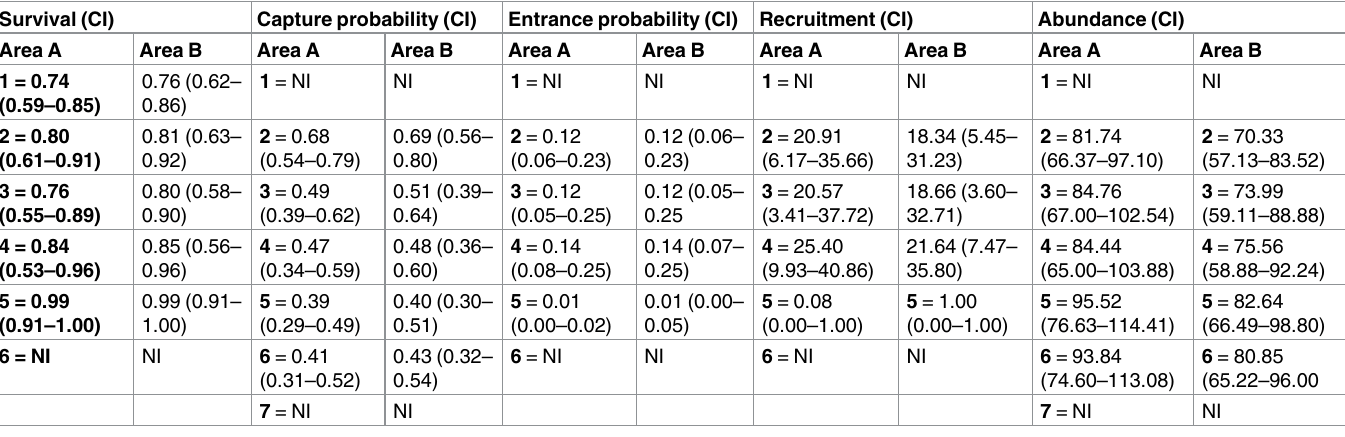
Table 4. Estimatesfor